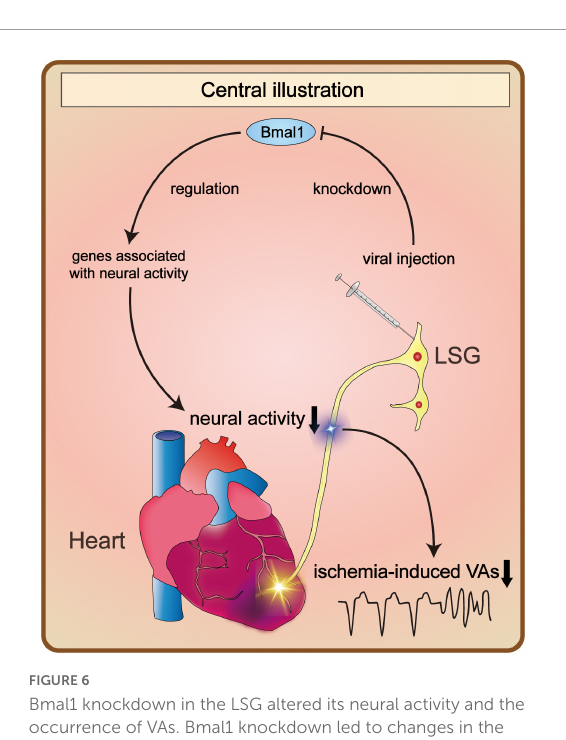
FIGURE6 Bmal1 knockdown in the LSG altered its neural activity and the occurrence of VAs. Bmal1 knockdown led to changes in the transcriptional levels of genes associated with neural activity. As a result, it contributed to the alteration of LSG neural activity. Consequently, the occurrence of VAs induced by myocardial ischemia was obviously decreased. LSG, left stellate ganglion; VAs, ventricular